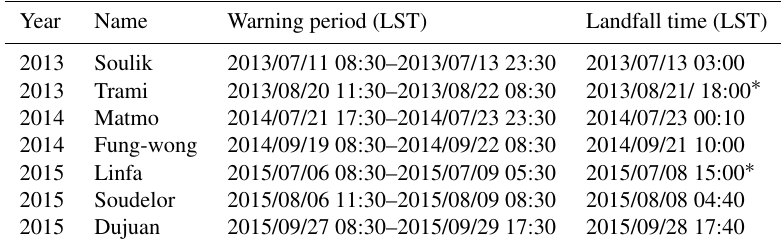
Table 1. Information of seven typhoons during 2013–2015 used to evaluate the system performance.